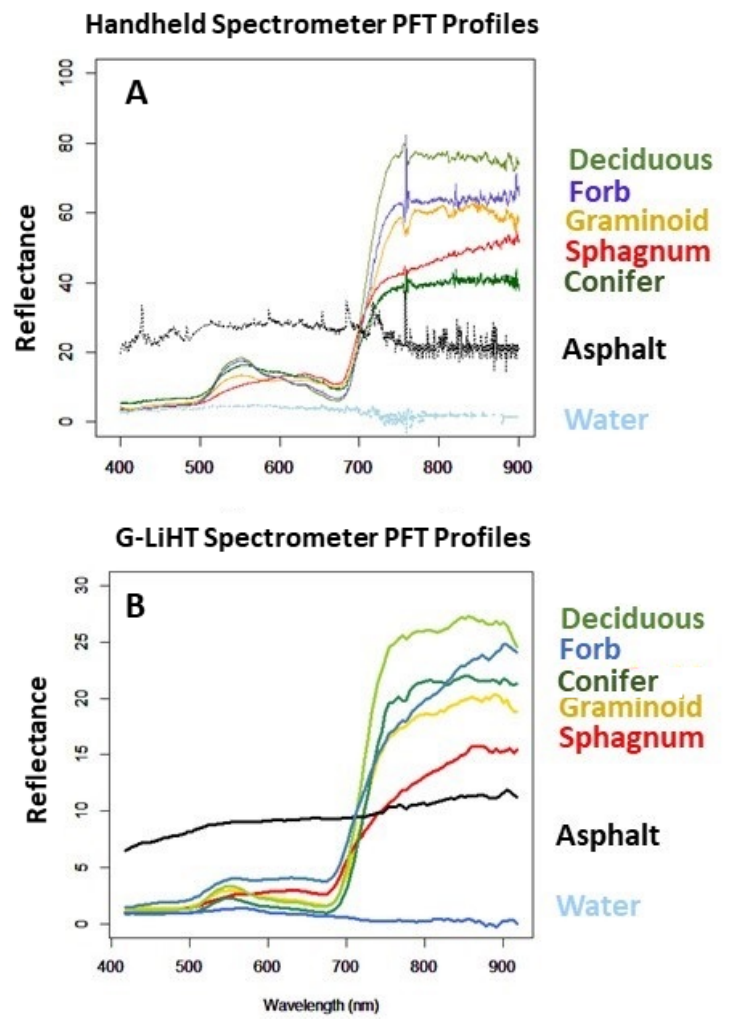
Figure 4. Spectral curves of PFT taken at Kenai wetland sites. ( A ). Averaged curves taken with a handheld spectrometer. ( B ). Spectral curves for each PFT, gathered from G-LiHT imagery pixels, shown here as a comparison to the handheld measurements.